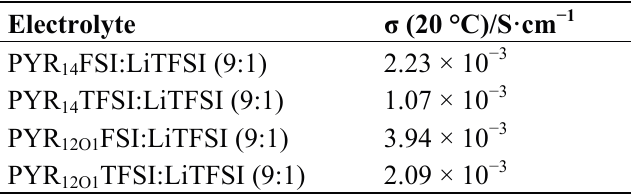
Table 3. Conductivity of the electrolytes at 20 °C.